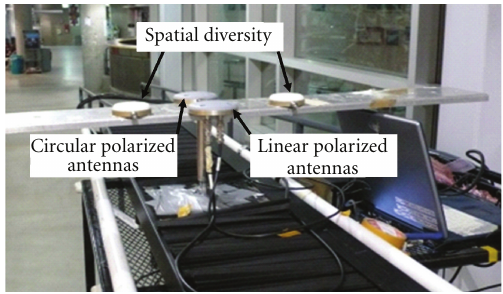
Figure 6: Three antenna diversity structures mounted on a moving linear